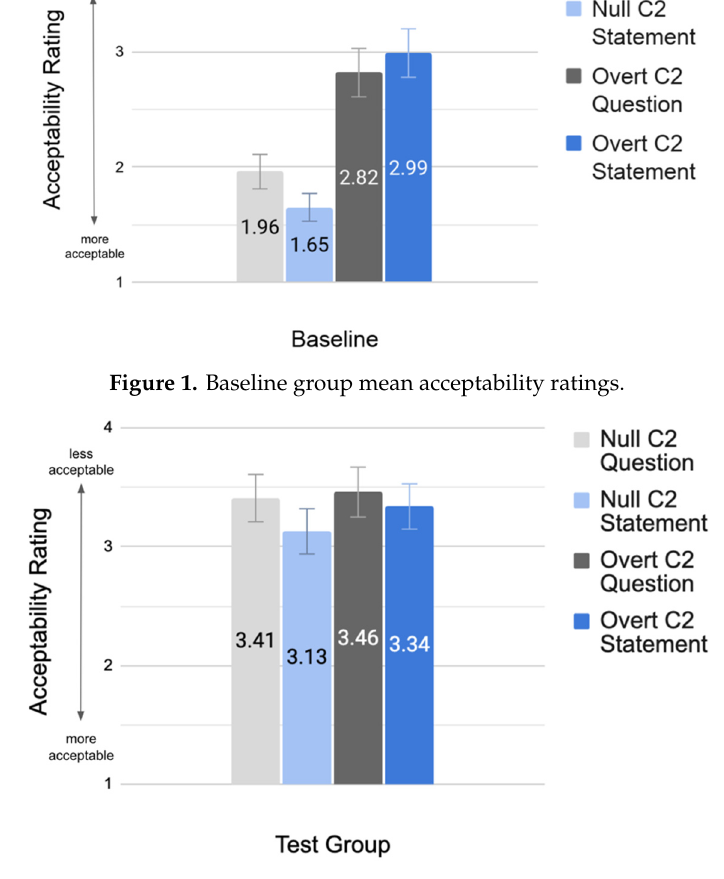
Figure 2. Test group mean acceptability ratings.